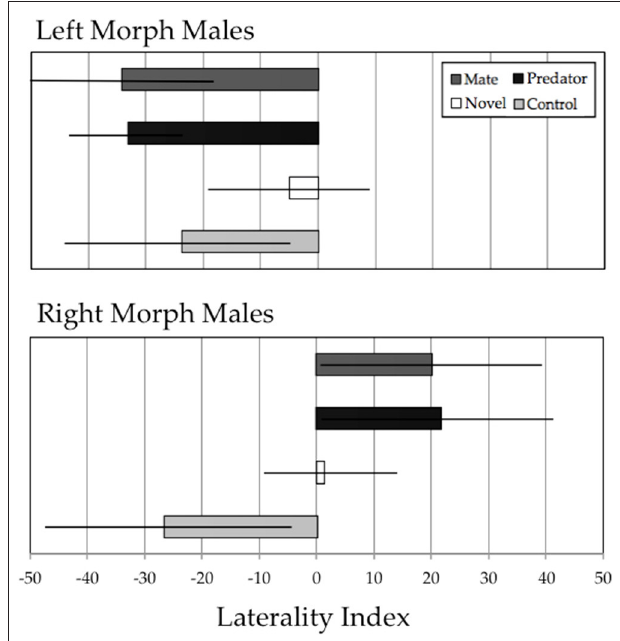
FIGURE 4 | Results of the detour assay for left morph males (upper panel) and right morph males (lower panel). Each group of males was exposed to four experimental stimuli: potential mate, predator, novel object, and empty tank control. The Laterality Index (LI) is defined in the methods; briefly, negative LI scores indicate detour to the left, and positive LI scores indicate detour to the right. Figure shows a bar chart with error bars depicting ± 2